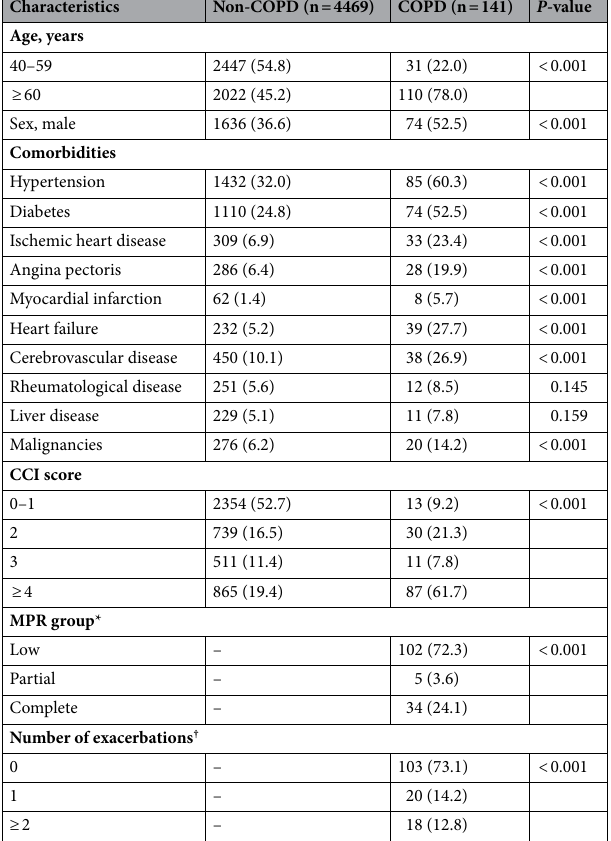
Table 1. Patient characteristics. Data are presented as numbers (%). COPD chronic obstructive pulmonary disease, CCI Charlson comorbidity index, MPR medication possession ratio. *Data are only for COPD patients. MPR was calculated as the sum of all days’ supplies of prescriptions filled divided by the time from the first filling of a prescription until the end of the measurement period. Patients were categorized into three only for COPD patients. Exacerbation was defined when the diagnostic code for COPD (J43 and J44 except J43.0) was present in conjunction with any of the following: (1) treatment with an antibiotic or systemic corticosteroids, (2) hospitalization, or (3) an emergency room visit.